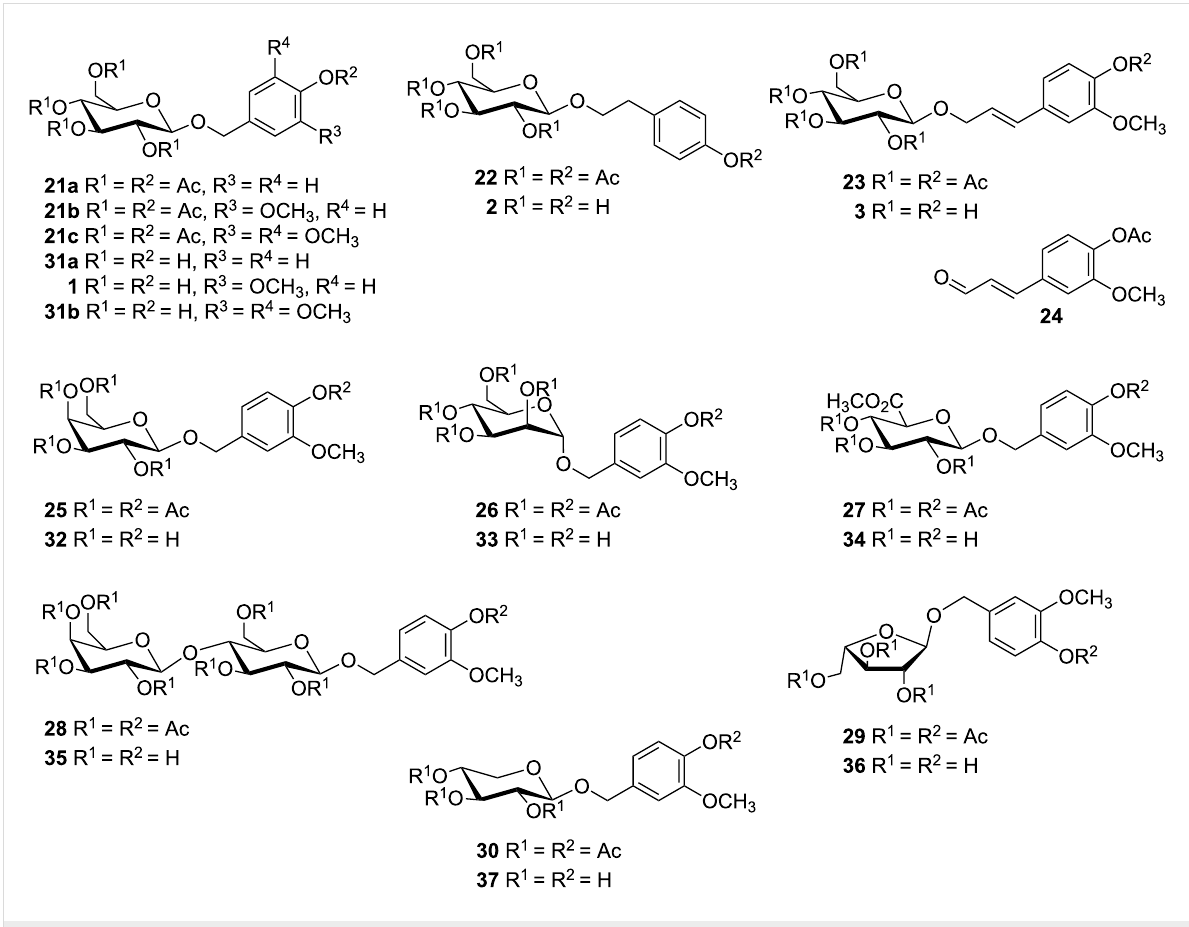
Figure 3: Overview of protected and deprotected products.